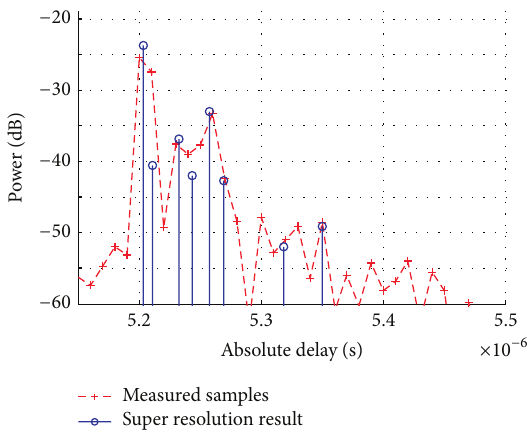
Figure 6: Example of a super resolution processed CIR snapshot.